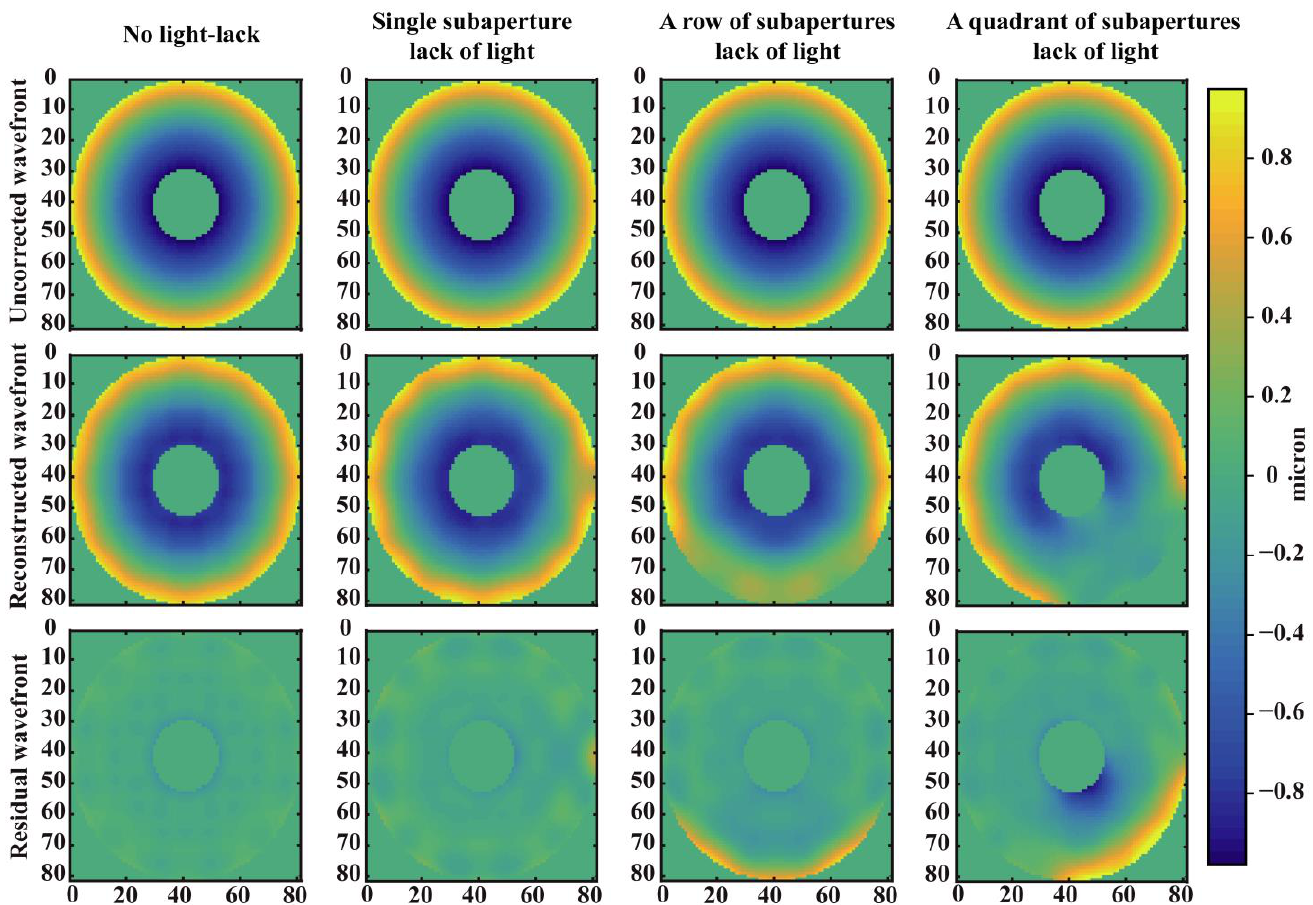
Figure 10. The influence of under-sampling on the statistical defocus in these three cases. The first row is the statistical aberration of defocus, the second row is the reconstructed wavefront under these three cases and the last row is the residual wavefront after correcting the initial defocus.